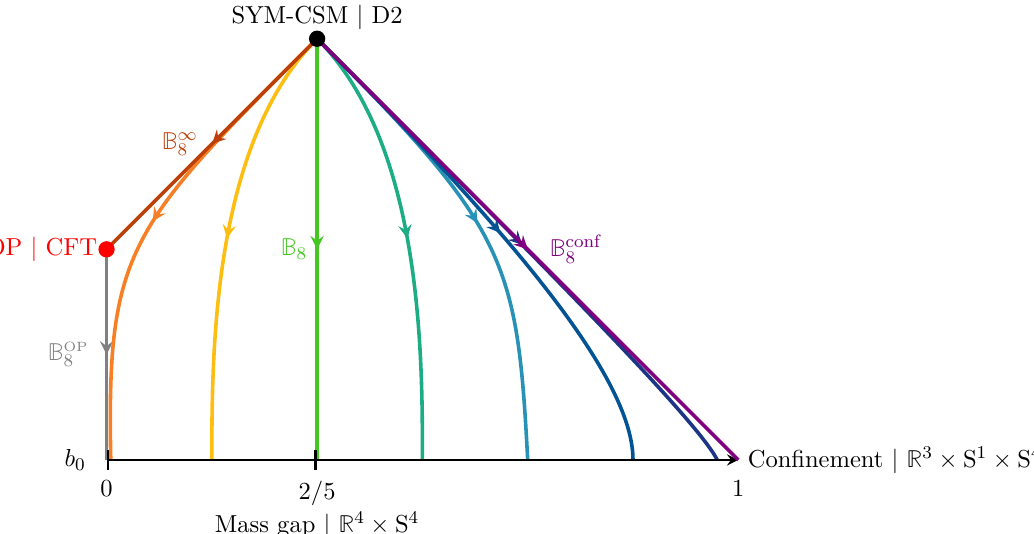
Figure 1. Pictorial representation of the B 8 family of solutions. The asymptotic UV regime is given by the 3D super Yang-Mills theory with Chern-Simons interactions for the gauge fields (SYM-CSM). As we come down in energy (descending in the plot) the RG flow generically drives the theory to an IR regime with a mass gap. Only for extreme value of b = 1 do we flow to a 0 confining theory, as depicted on the bottom-right corner of the plot. For b = 0 the IR is governed 0 by an Ooguri-Park (OP) conformal fixed point. The hue or the warmth of the curves will be roughly in one-to-one correspondence with the values of b on the horizontal axis; in the figures to follow 0 we will try to maintain this